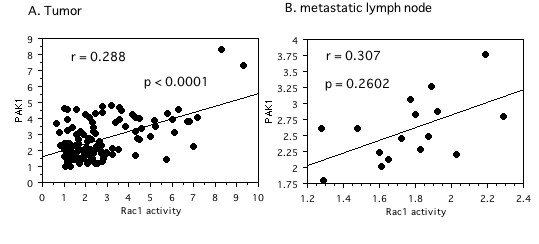
Spearman rank correlation coefficient relationship between expression levels of Rac1 activity and Pak1. X axis is an independent variable. Y axis is a dependent variable. A; Tumor tissues. B; Metastatic lymph node tissues.